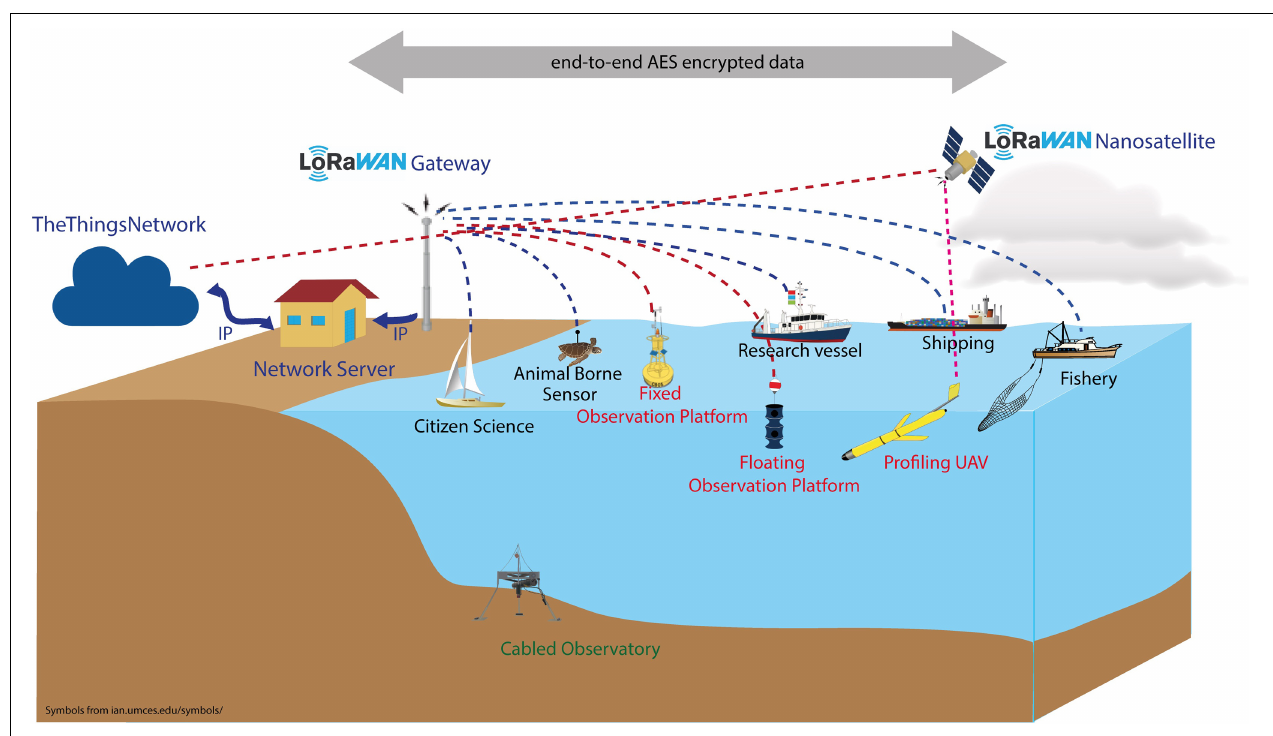
FIGURE 2 | Schematics of the IoT communication network in the ocean. The names in red identify dedicated platforms, in blue cooperative platforms, in green cabled platforms. The dashed lines represent the communication channels connecting platforms to the gateway using a specific wireless communication protocol depending on local availability and cost. The gateway is connected to the network server by any IP communication technology available. The network server connects to a number of specific application servers which make the data accessible through a web browser. The transmission channel employs an end-to-end AES encryption protocol. The schematics includes gliders that in the future may be connected to the system via LoRaWAN satellite communication as the other open-ocean